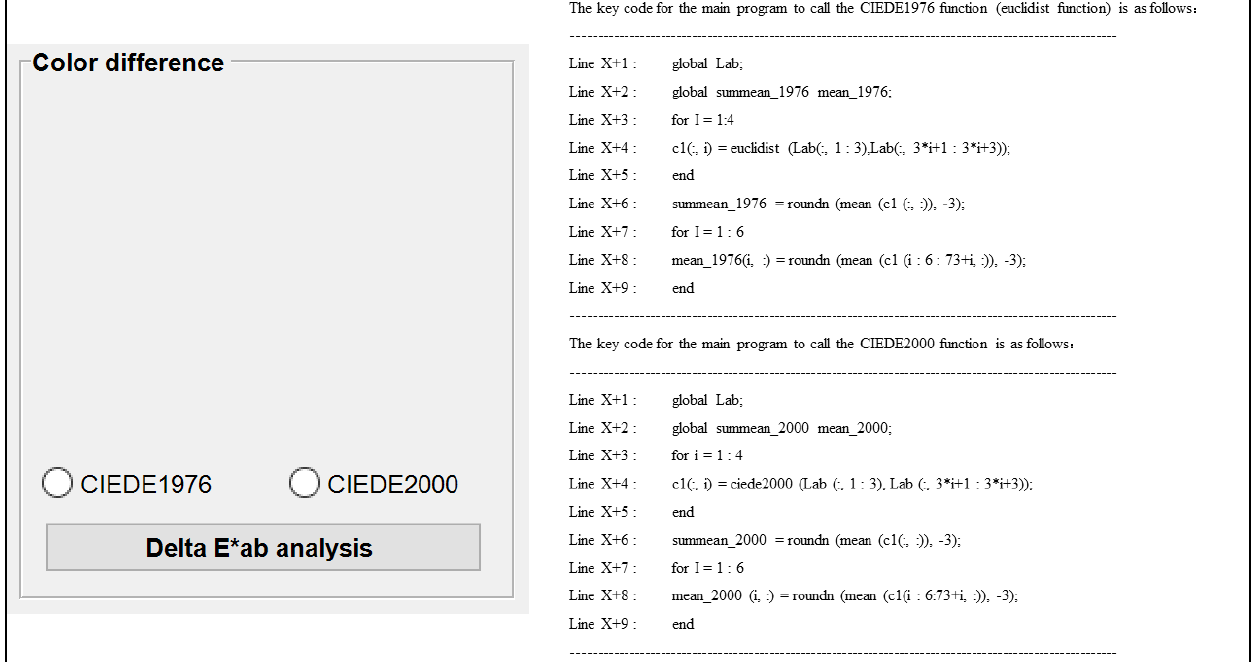
Figure 14. Interface design and demonstration of its calling codes in Module 4. Table 4. Types, labels and roles of controls used in the Module 4 interface.